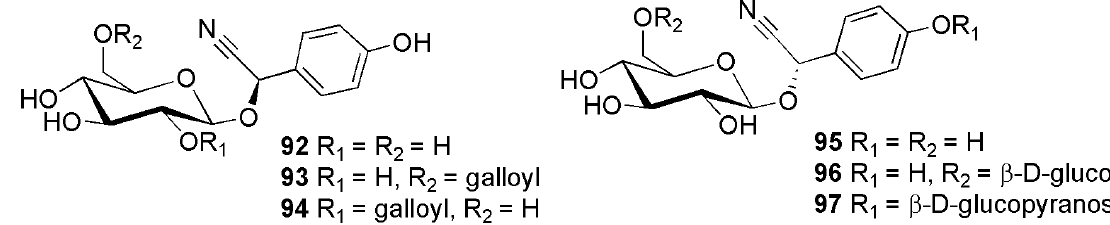
Figure 15. Cyanogenic glycosides group C-5, para -hydroxyphenyl derivatives: taxiphyllin ( 92 ), taxiphyllin 6 ′ - O -gallate ( 93 ), glochidacuminoside D ( 94 ), dhurrin ( 95 ), dhurrin 6 ′ -glucoside ( 96 ) and proteacin ( 97 ).